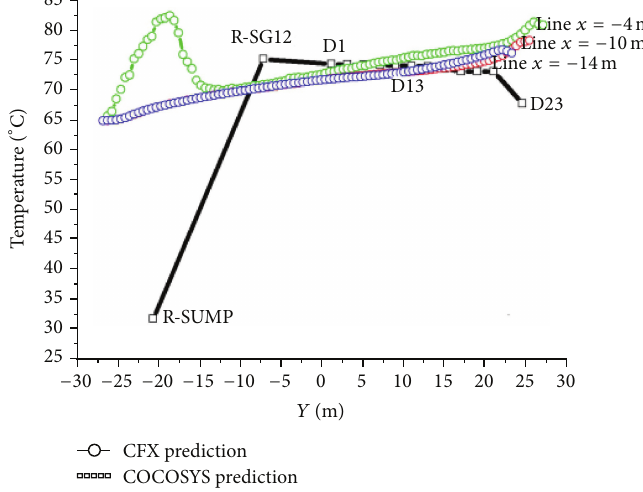
Figure 7: Comparison of temperature